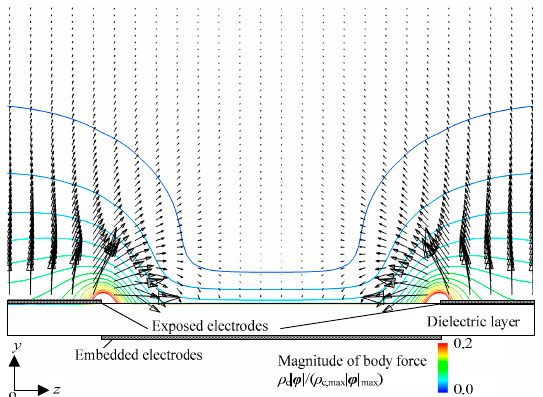
Figure 8. Predicted vectors of the body force and contours of the magnitude of the force vector.